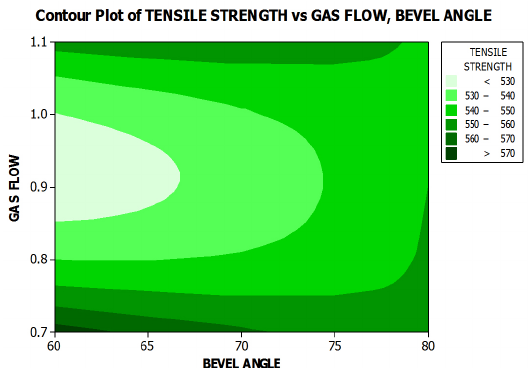
Figure 2. Contour plot of Tensile strength vs Gas flow, Bevel